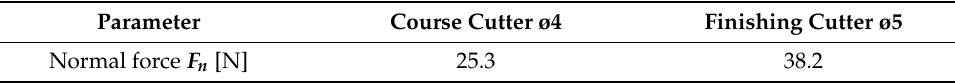
Table 6. The determined values of the normal force F n for the two cutters